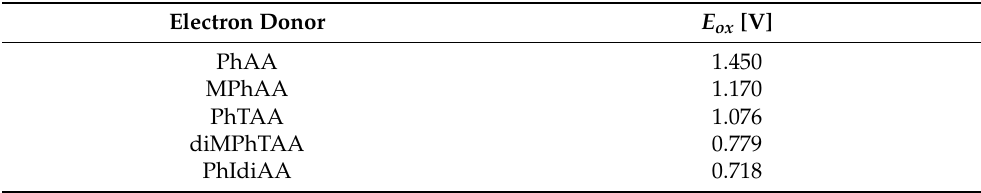
Table 3. The oxidation potentials of the electron donors